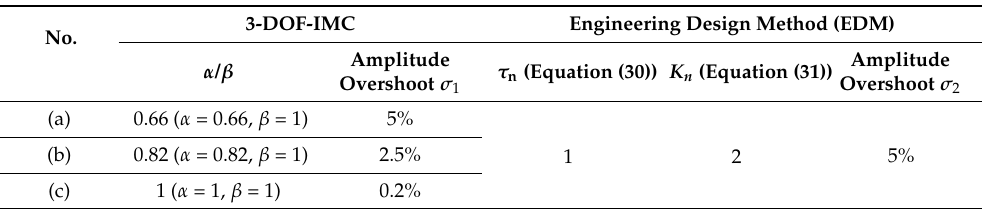
Table 9. The vibration suppression ability comparison of the 3-DOF-IMC and the EDM, with corre- sponding conclusions.